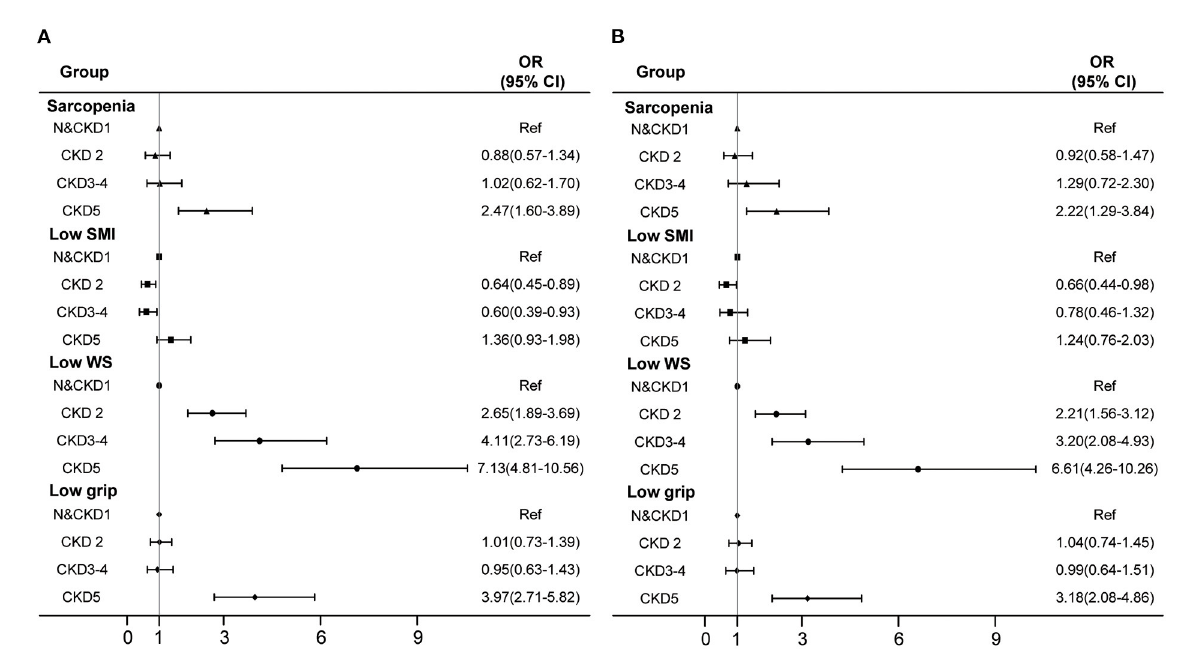
FIGURE2 Association of different CKD stages with sarcopenia and its components. (A) crude model. (B) adjusted with age, sex, BMI, smoking, drinking, occupation, widowed, education, physical activity level, hypertension, diabetes, dyslipidemia, CHD and stroke. N, normal; CKD, chronic kidney disease; SMI, skeletal muscle mass index; WS, walking speed; CI, confidence interval; OR, odds